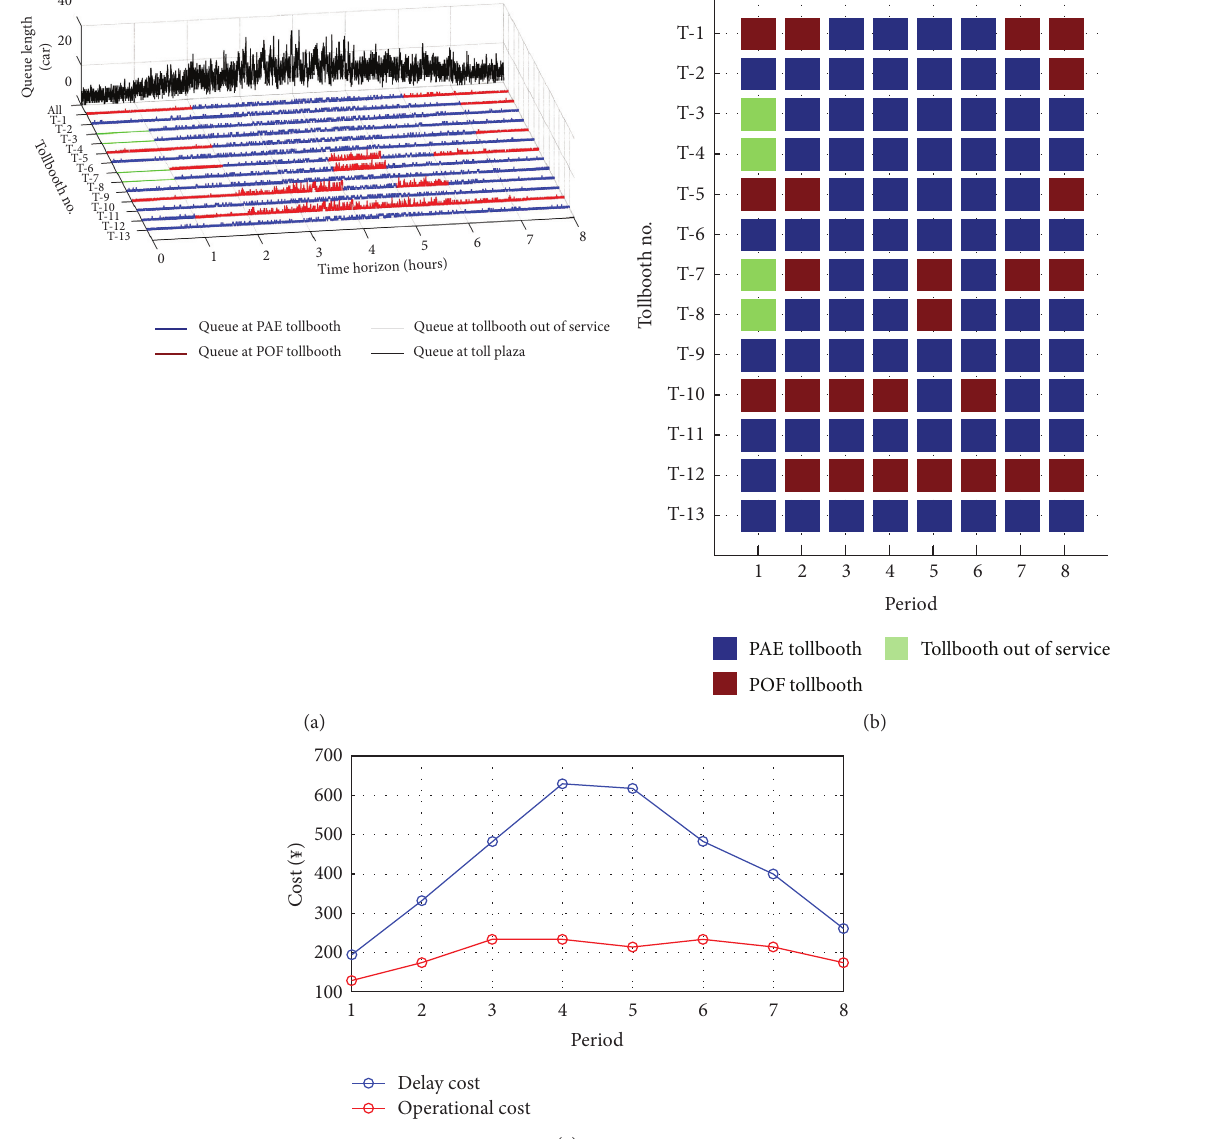
Figure 15: Recommended tollbooth operation scheme and its performance with weight of operational cost � 0.2. (a) Queue length evolution with time. (b) Best tollbooth operation scheme. (c) Costs in each